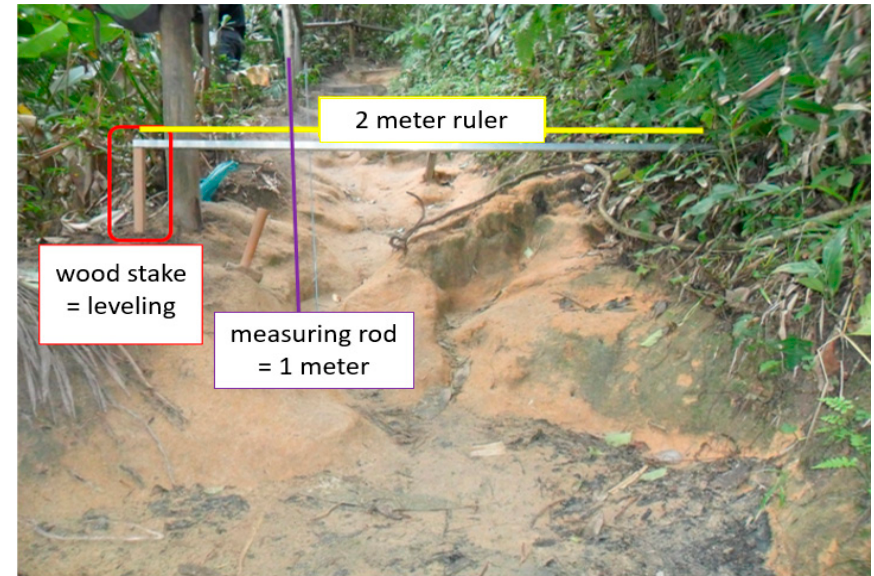
Figure 3. Measuring soil microtopography using the erosion bridge on Caixa D’Aço pool trails. Photo: L. Rangel (2016).